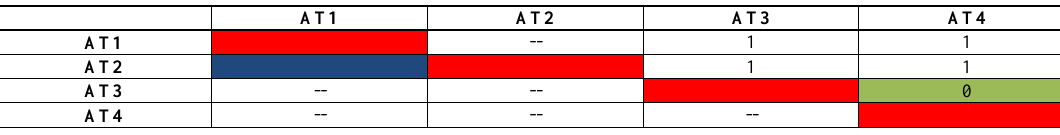
Table 20. Dominating interaction matrix of actors for process PR5.